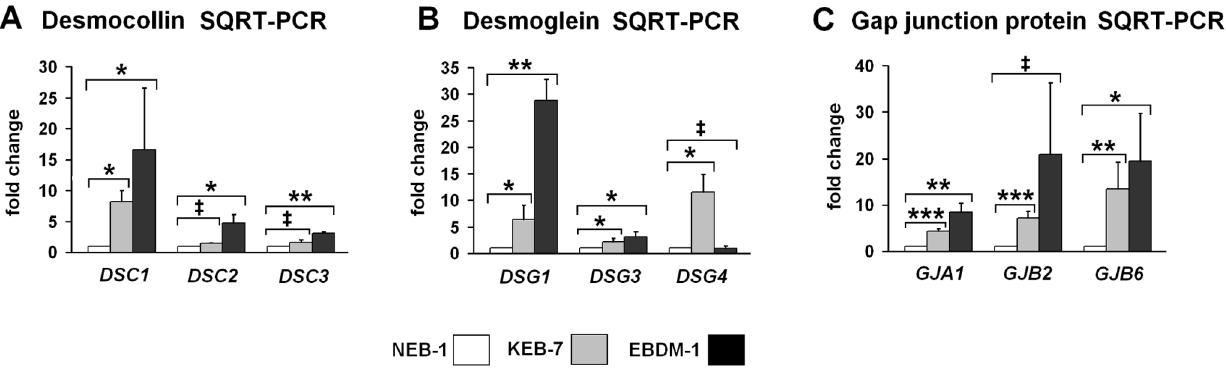
Figure 5. Expression of junction proteins in EBS-DM cell lines. A. SQRT-PCR of desmocollin mRNA expression in NEB-1, KEB-7 and EBDM-1 (n=3 to n=4). DSC1 shows the highest increase in both EBS-DM cell lines. DSC2 and DSC3 are increased only in EBDM-1 but not in KEB-7. B. SQRT- PCR of desmoglein mRNA expression in NEB-1, KEB-7 and EBDM-1 (n=3 to n=5). DSG1 shows the highest increase in EBDM-1. Only a slight increase was observed for DSG3 . DSG4 is only significantly increased in KEB-7. C. SQRT-PCR of gap junction protein mRNA expression in NEB-1, KEB-7 and EBDM-1 (n=3 to n=5). GJA1 and GJB6 expression is increased in both EBS-DM cell lines. GJB2 is only increased significantly in KEB-7. Student’s t -test was performed with p values: * # 0.05, ** # 0.01, *** # 0.005, ` =no significant difference between investigated cell lines.